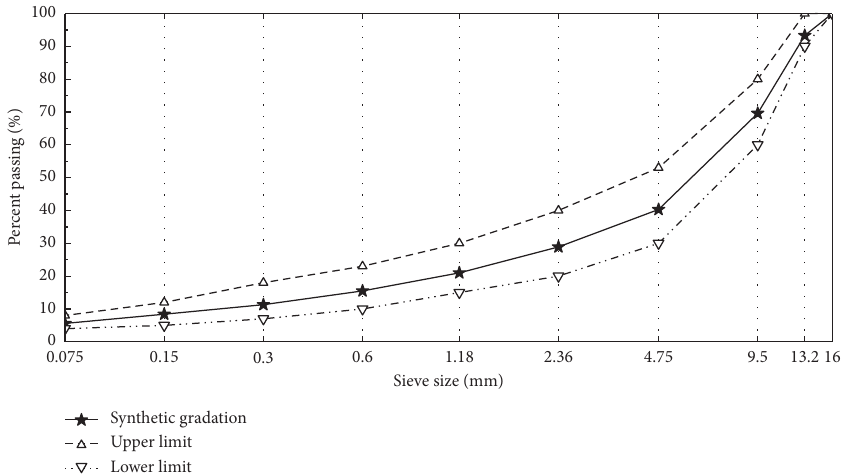
Figure 1: Asphalt mixture gradation curve in this paper.